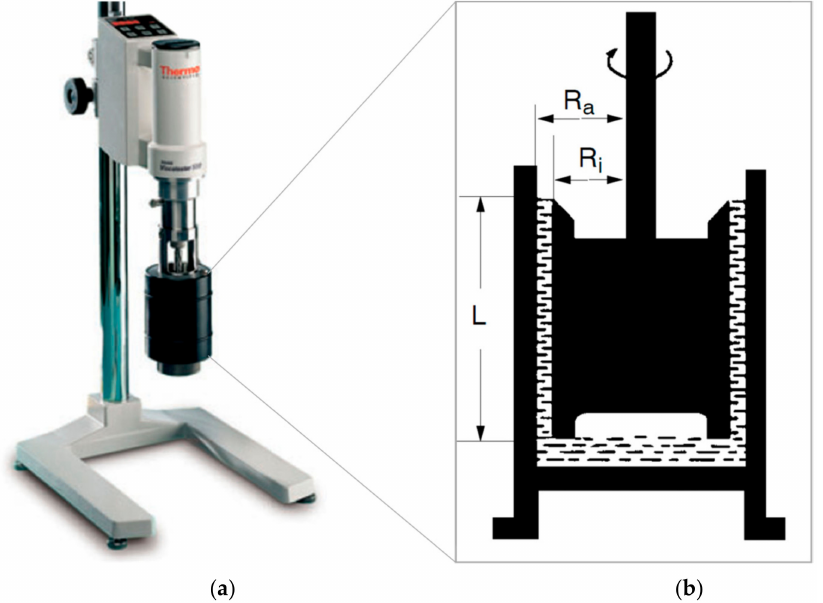
Figure 3. HAAKE Viscotester 550 employed for the rheometric tests: ( a ) device and ( b ) sample details (L = 60 mm, R i = 20.04 mm, and R a = R i + 0.96